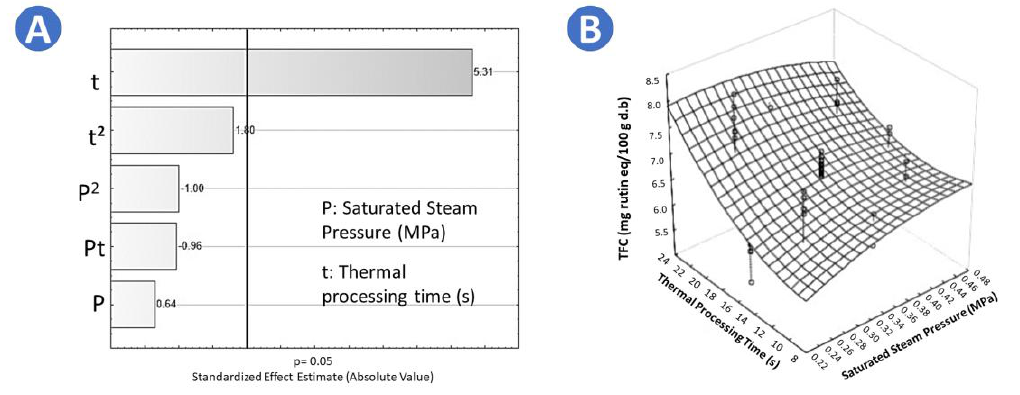
Figure 2. Effects of steam pressure (MPa) and thermal processing time (s) on the total flavonoids content (TFC) of swell-dried chokecherries. ( A ) Pareto chart and ( B ) surface response plot.